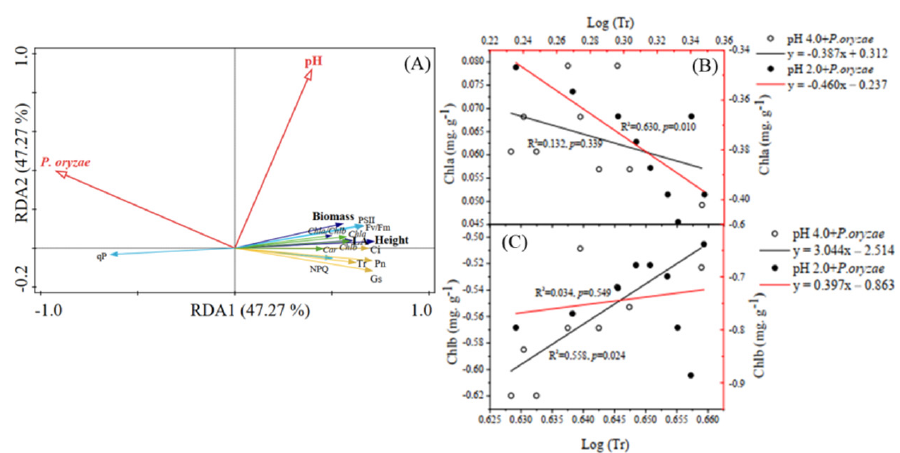
Figure 5. Redundancy analysis (RDA) of growth traits and photosynthetic properties under the combined effect of SAR and P. oryzae ( A ). Linear regression between Tr and Chla content under SAR and P. oryzae treatment ( B ). Linear regression between Tr and Chlb content under SAR and P. oryzae treatment ( C ). The angle and length of the arrows indicate the direction and strength of the relationship of each index, respectively. In the picture, P. oryzae is the inoculation treatments of P. oryzae , pH is the pH of SAR, LA is leaf area, Chla is the content of chlorophyll a, Chlb is the content of chlorophyll b, Car is the content of carotenoid. Chla/Chlb is the ratio of Chla to Chlb, Pn is net photosynthetic rate, Ci is intercellular CO 2 concentration, Tr is transpiration rate, Gs is stomatal conductance, Fv/Fm is the maximal efficiency of photosystem II (PSII) photochemistry, PSII is the effective efficiency of PSII photochemistry, qP is photochemical quenching coefficient, NPQ is non-photochemical quenching coefficient. The regression equation R 2 and their significance level ( p < 0.05) are shown.